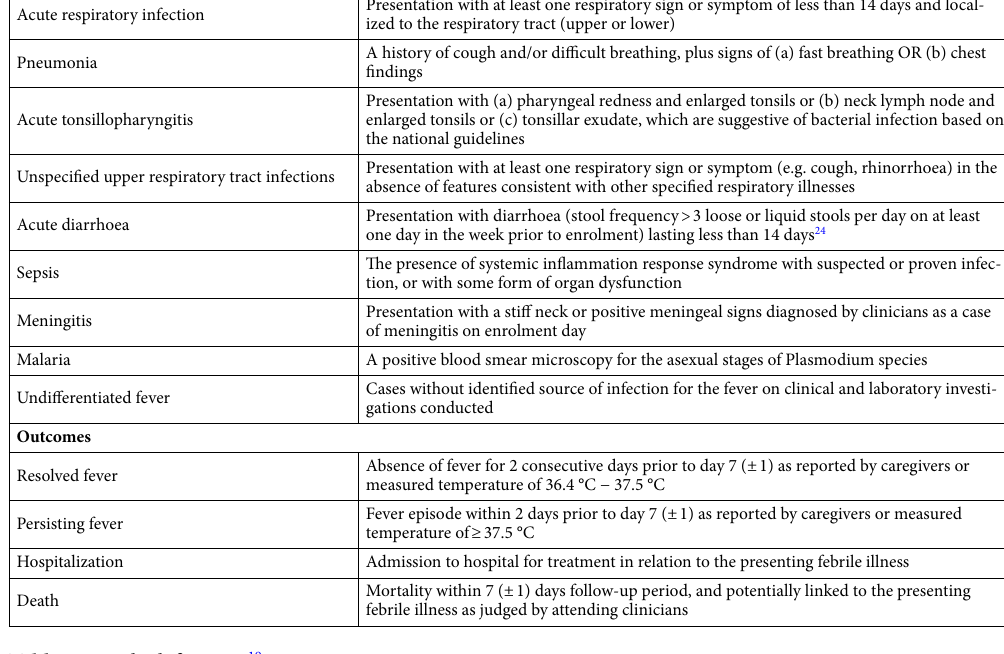
Table 1. Study definitions 19